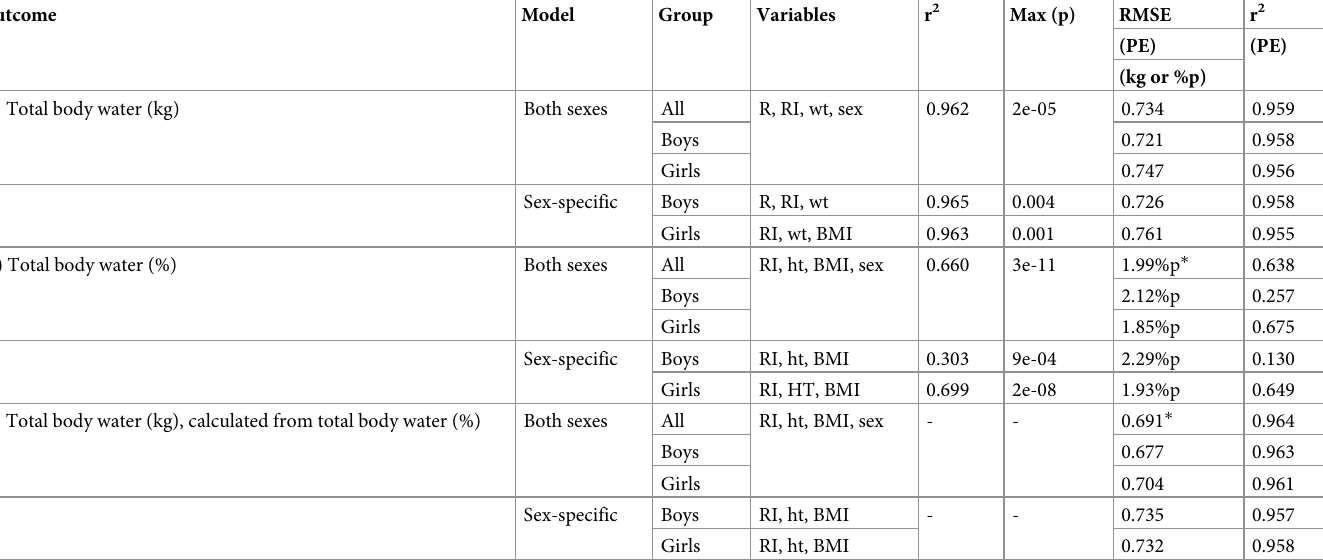
Table 3. Predictive equations for total body water (TBW) in kg and TBW as a percentage of weight. For each outcome, out-of-sample performance metrics (the last two columns) are given for the combined data and for boys and girls separately. Preditive models were fitted for both sexes together (sex specific intercept only) and sepa- rately for each sex (sex specific